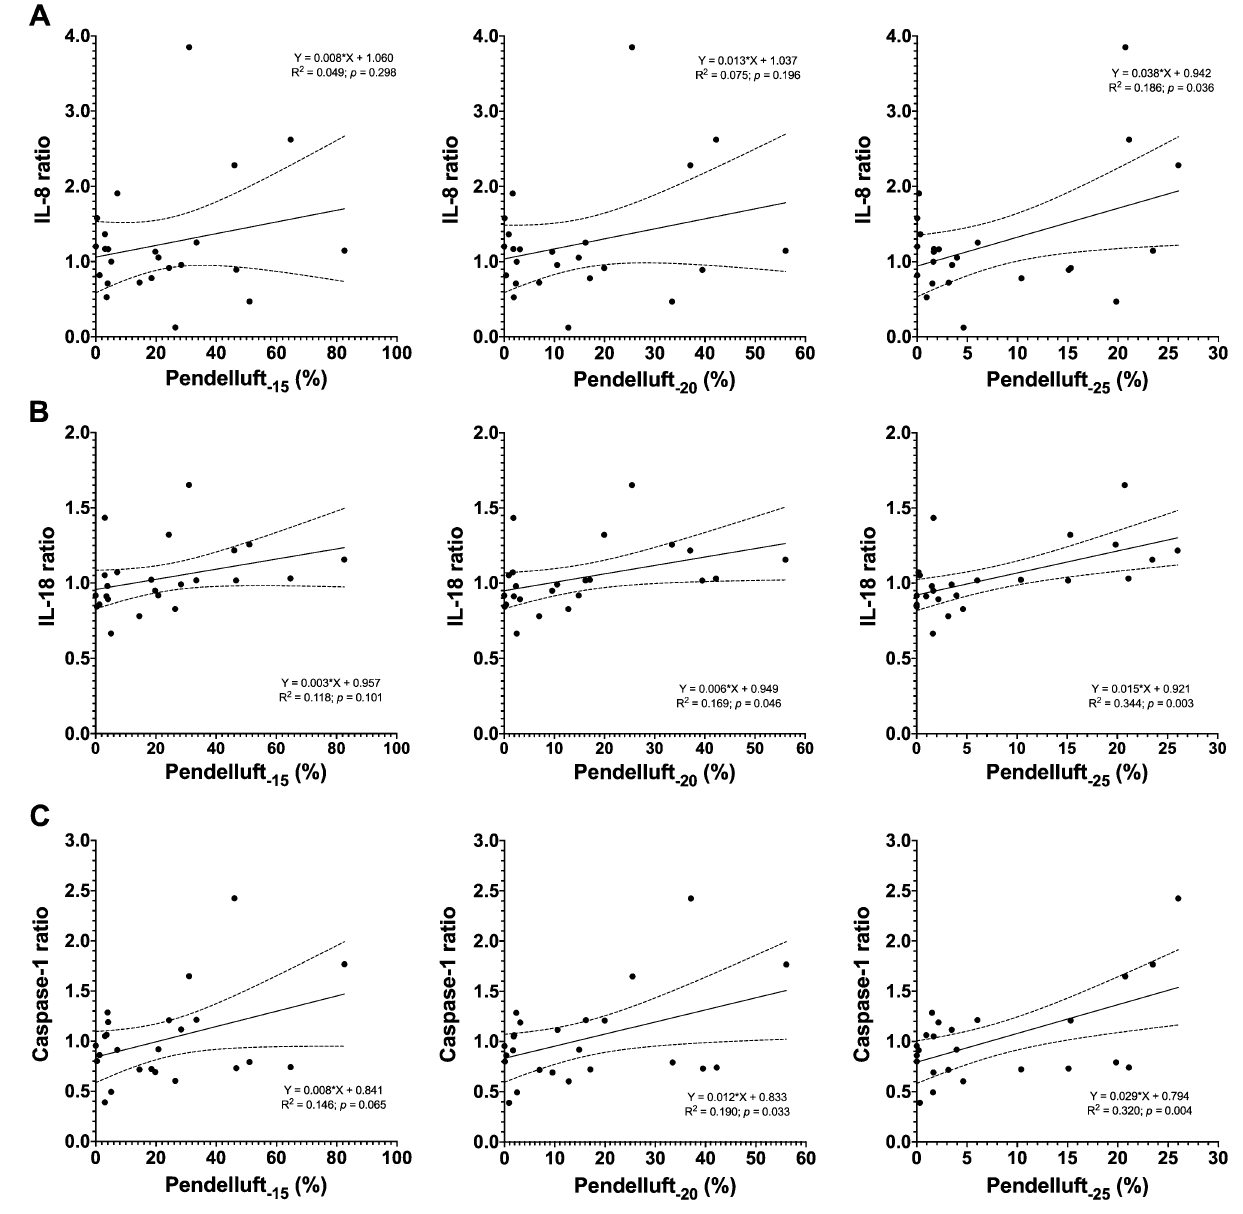
Figure 2. Scatter plots and regression analysis between ( A ) IL-8, ( B ) IL-18, ( C ) Caspase-1 ratios and frequencies of pendelluft magnitude − 15, − 20 and − 25%. Biomarker ratio [(biomarker at T 4 )/(biomarker at T 0 )] and the mean of pendelluft frequencies at different cut-off points of pendelluft magnitude (− 15, − 20 and − 25%), through the 4 h period of observation, were obtained for each patient. Pendelluft -15 : mean of pendelluft frequency at magnitude of − 15%; Pendelluft -20 : mean of pendelluft frequency at magnitude of − 20%; Pendelluft -25 : mean pendelluft frequency at magnitude of − 25%. ΔP es : mean of negative deflection of esophageal pressure from the onset of inspiratory effort during the ventilatory cycle; ΔP L : mean of tidal change in transpulmonary pressure. V T : tidal